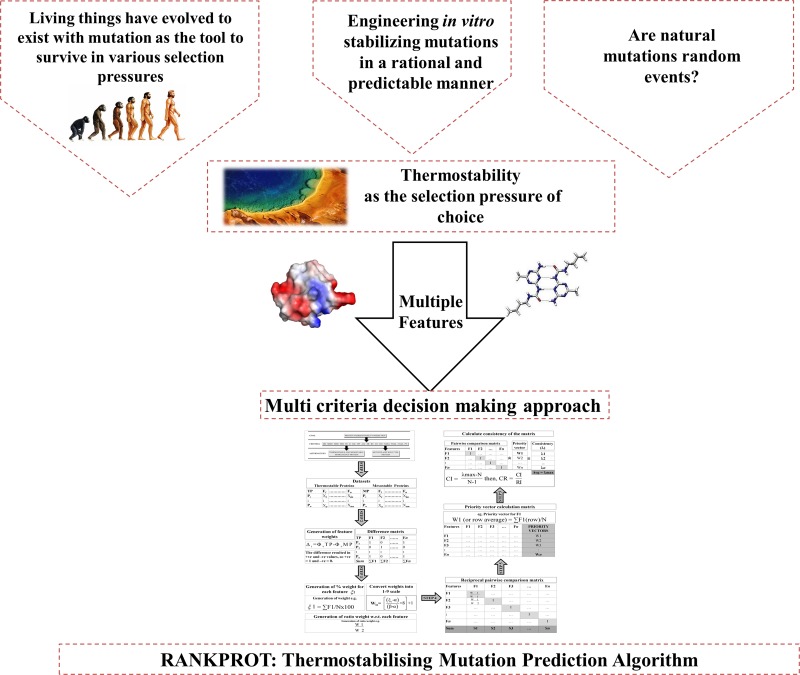
Overview of the method of developing RankProt with thermostabiility as the selection pressure of choice.The line drawings were made by the authors. All other images in this figure were adapted from Wikipedia possessing CC BY-SA 3.0 license.